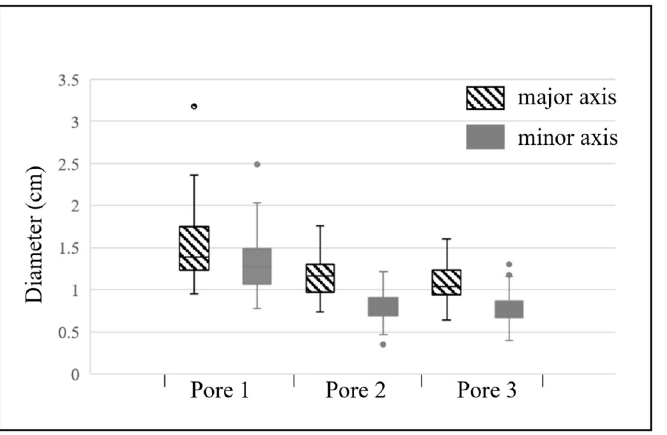
Fig 7. Measurements of the three pores on the coconut endocarp.